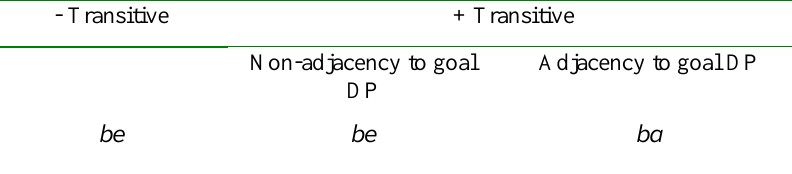
Table III. Distribution of be and ba